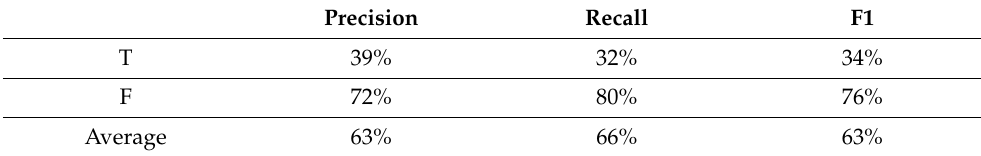
Table 6. The results that were produced by the Random Forest algorithm, without our special similarity features.